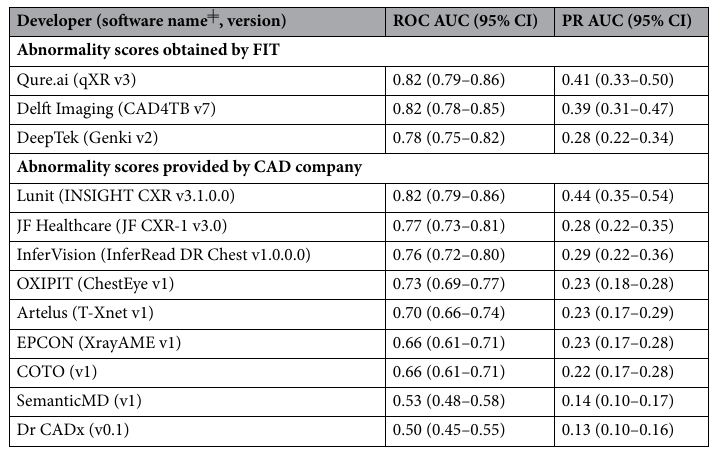
Table 2. Area under the ROC and precision-recall (RC) curves for each CAD software. ROC AUC area under the receiver operating characteristic curve, PR AUC area under the precision-recall curve. ╪ Software name omitted if none available.